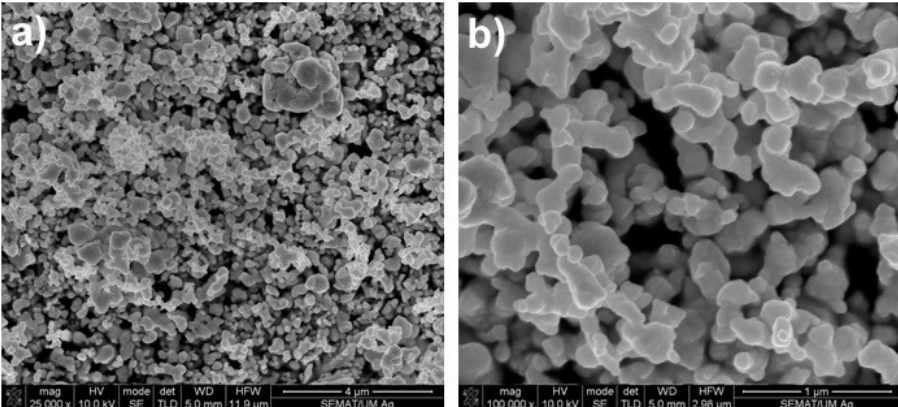
Figure 2. SEM micrographs of silver powder: ( a ) 25,000× and ( b ) 100,000× of amplification.